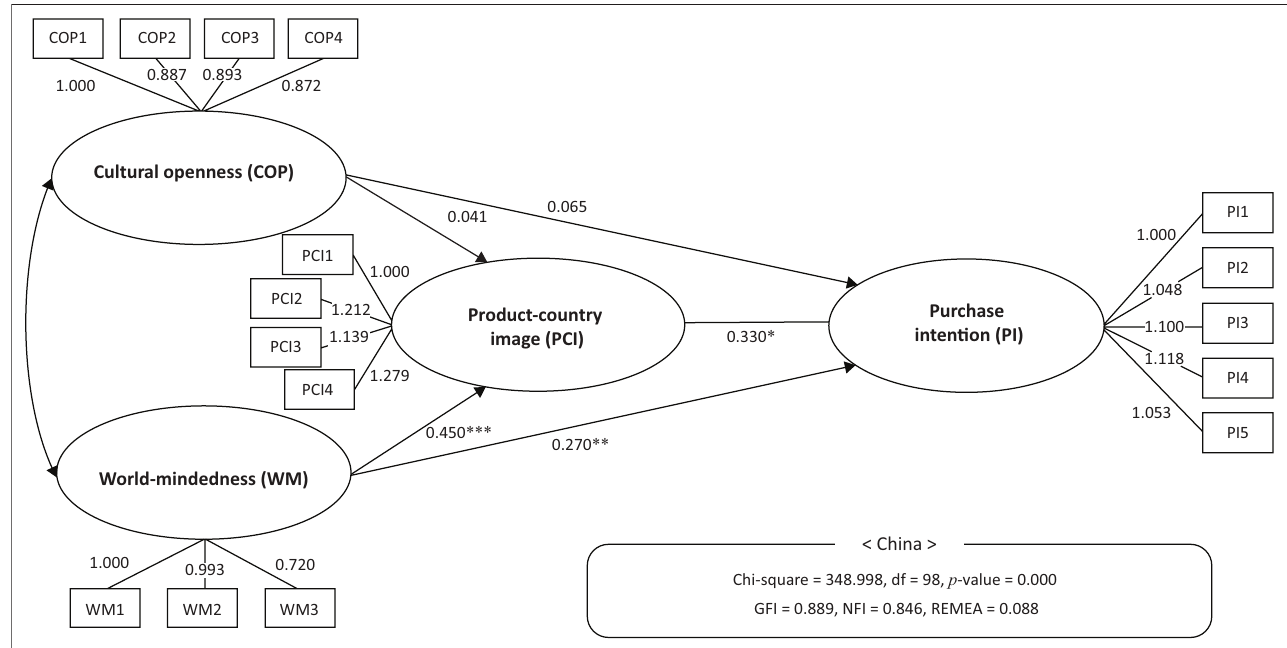
FIG URE 3: Structural model